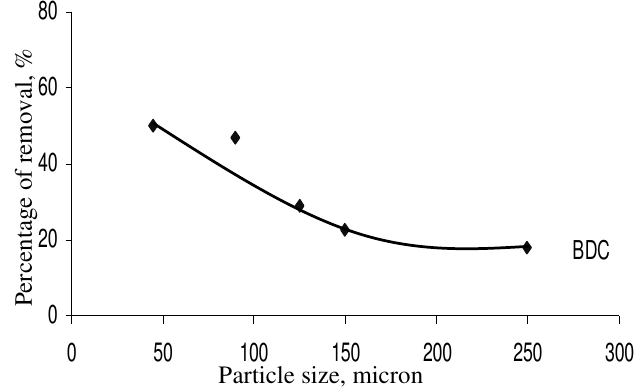
Figure 4. Effect of particle size on the removal of lead(II) ions by BDC